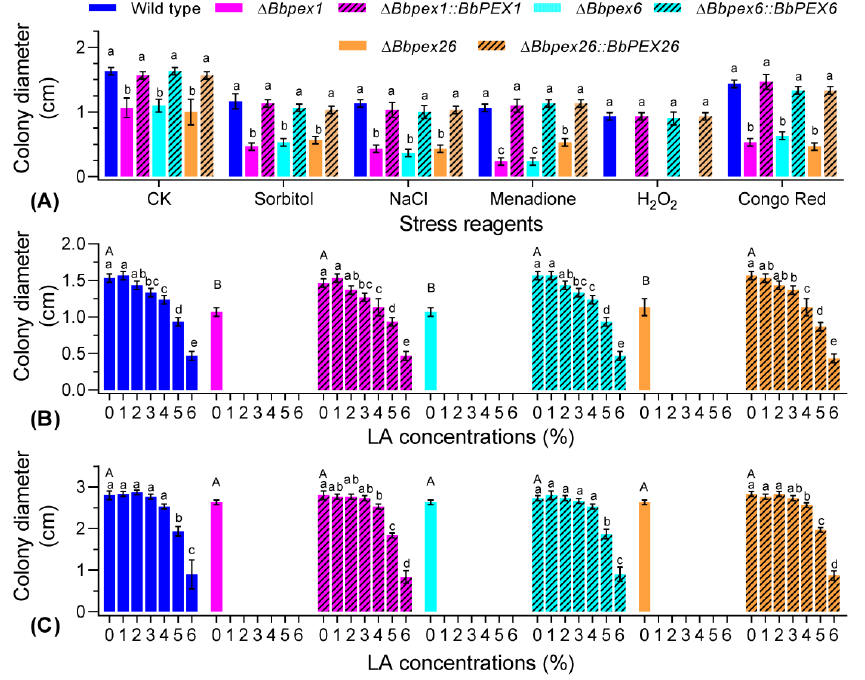
Figure 4. Vegetative growth under chemical stress. ( A ) Stress chemicals were included in the CZA to generate various stresses. CZA without stress reagent was used as a control (CK). Numbers (0–6) indicate the gradient concentrations of LA. ( B ) In CZA, LA concentrations ( v/v ) were set as 0%, 0.002%, 0.005%, 0.01%, 0.02%, 0.04%, and 0.05%. ( C ) In TPA, LA concentrations were set as 0%, 0.002%, 0.005%, 0.01%, 0.02%, 0.05%, and 0.1%. The conidial suspension was inoculated onto plates and cultured at 25 ◦ C. Seven days later, the colony diameter was examined. The lowercase letters indicate a significant difference in the indicated phenotype among different strains, while the uppercase letters indicate a significant difference in colony diameter among different strains under control condition (Tukey’s HSD: p < 0.05). Error bars: standard